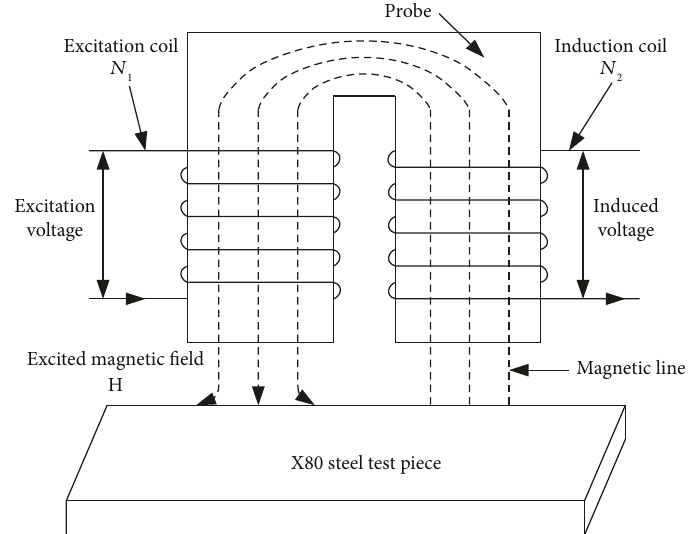
Figure 7: Schematic diagram of closed magnetic